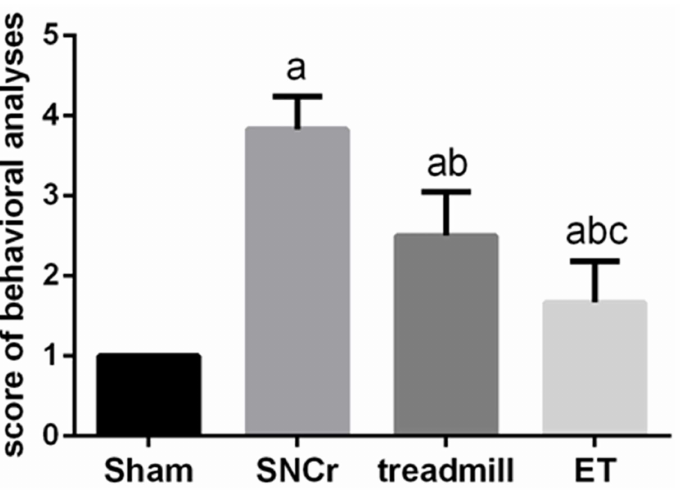
Fig 2. Comparison of toe-spreading index for behavioral analyses. After 4 weeks of treatment, comparedwith Sham group, a P < 0.05;Comparedwith SNCr group, b P < 0.05;Comparedwith treadmill group, c P < 0.05.